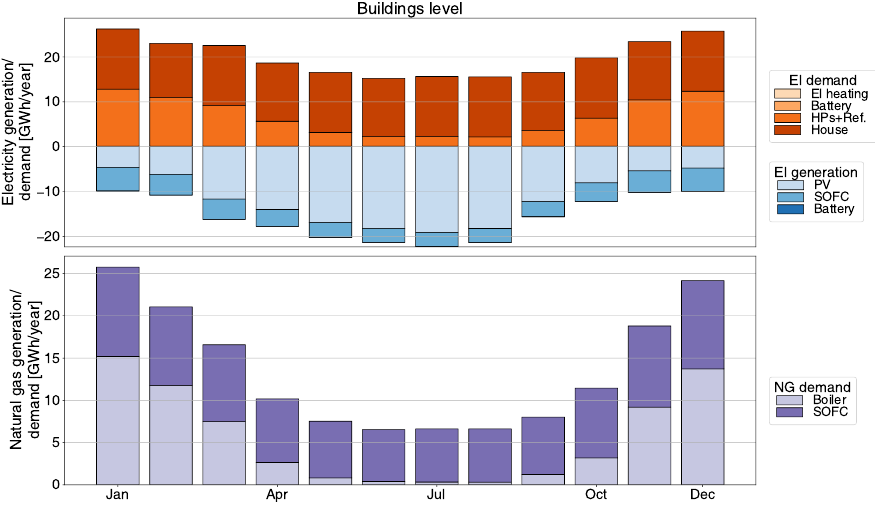
Figure 20. Breakdown of electricity/natural gas import/export by month, for Génève